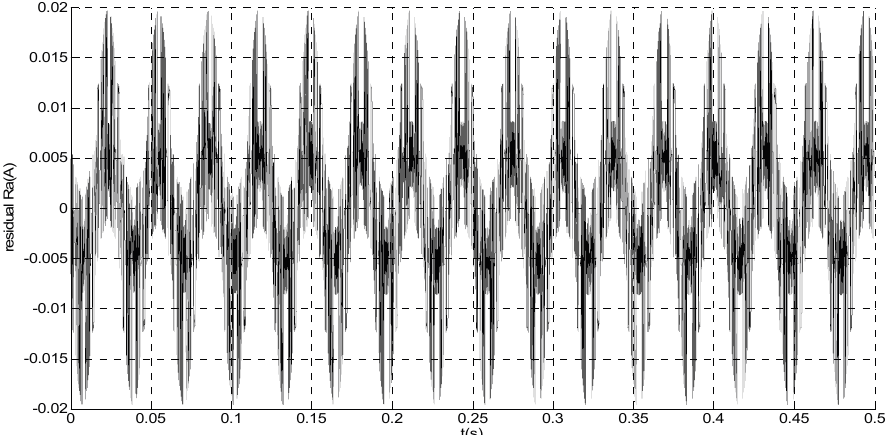
Figure 13. Simulation results of the actual and observation of β axis stator current.